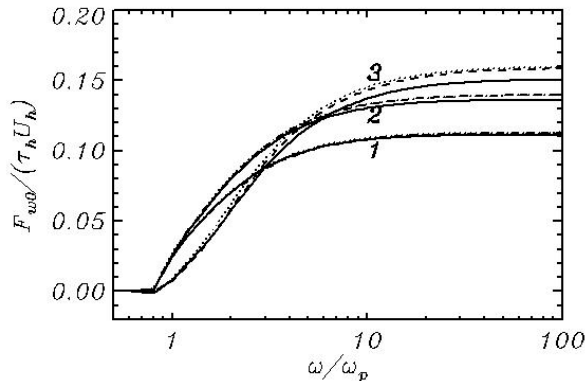
τ Figure 11. The integral energy flux to waves F w 0 normalized by the external energy flux τ H U H at Figure 11. The integral energy flux to waves 0 w F normalized by the external energy flux H H U at height z = H as a function of ω / ω p and Ω p : 1— U H = 14 m / s; 2—22 m / s ; 3—30 m / c. Solid curves = = Ω ω ω as a function of / and : 1— 14 / ; H U m s 2— 22 / m s ; 3— 30 / . м с height z H correspond to Ω p = 1, a dotted curve correspond to Ω p = 1.9, dashed curves correspond to Ω p = 2.8. p p Ω = Ω = , a dotted curve correspond to 1.9, dashed curves Solid curves correspond to 1 p p The flux of energy comes to the saturation level at ω / ω p ≈ 100 while the flux of momentum Ω = correspond to 2.8 . remains growing up to ω / ω p ∼ p